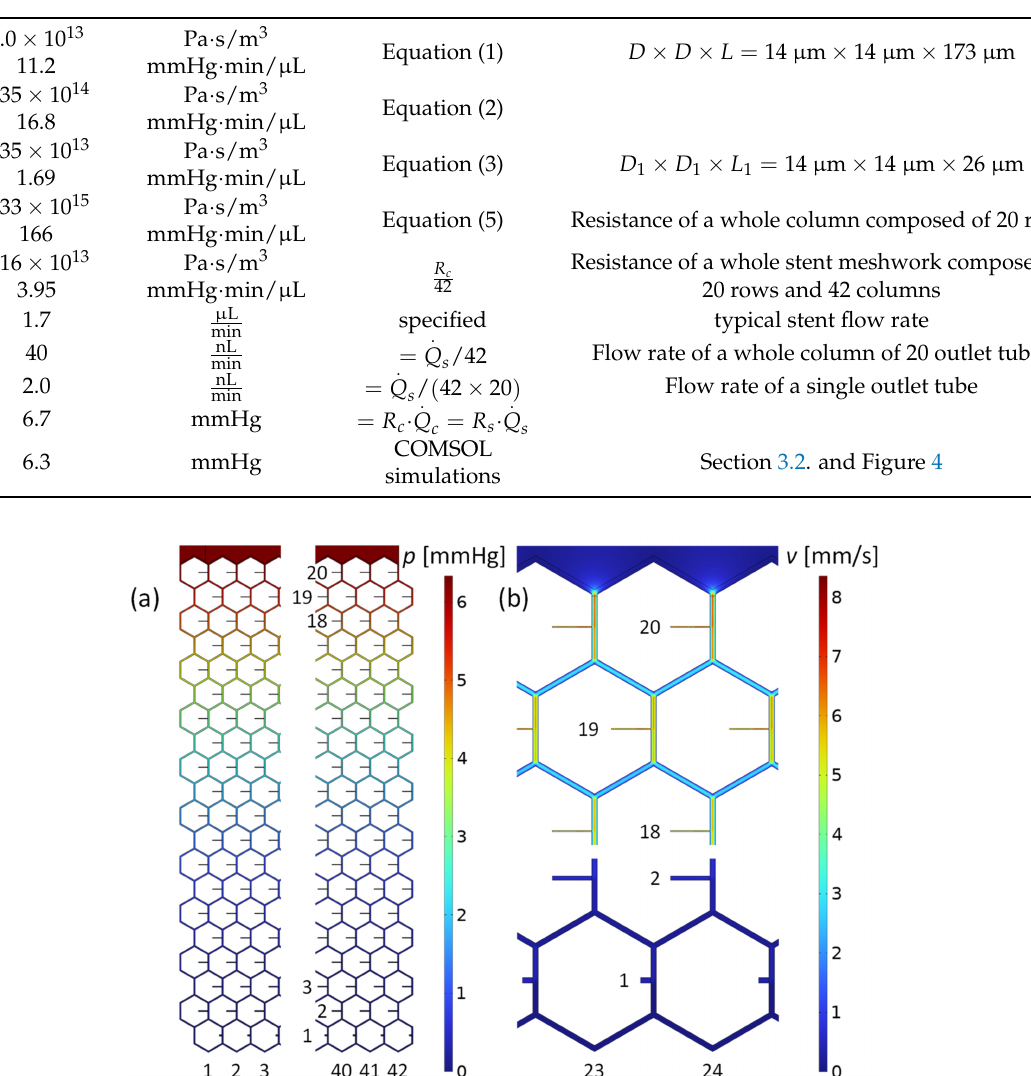
and the outlet pressure of min